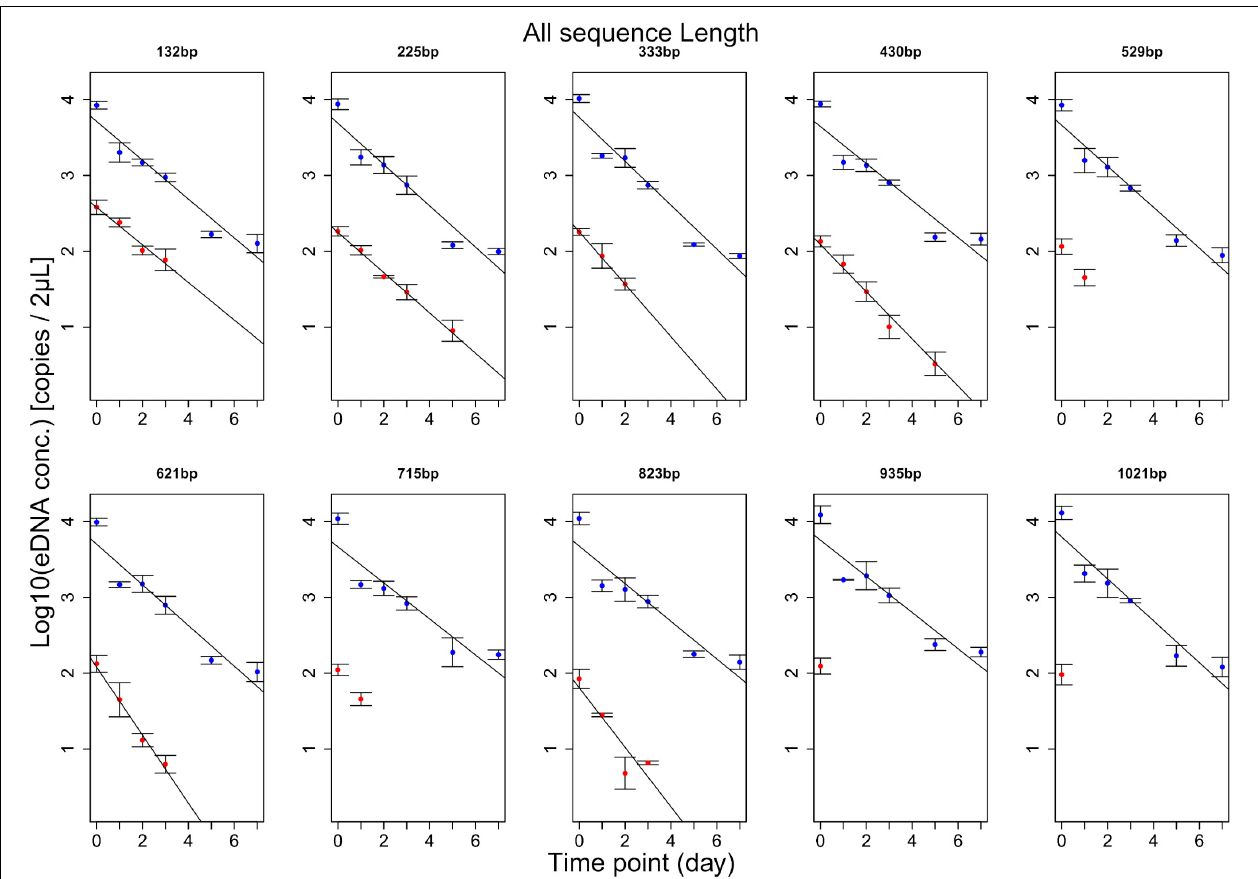
FIGURE 4 | Results of experiment 2. The change over time for each amplicon length is shown. The blue line shows the change in total eDNA copy number, and the red line shows the change in intracellular eDNA copy number. For 529, 715, 935, and 1,021 bp, only two or less time points were detected, so statistical processing was not performed. The total eDNA has the same result regardless of the target sequence length, but the intracellular eDNA tends to have a slight change in the regression line as the target sequence length